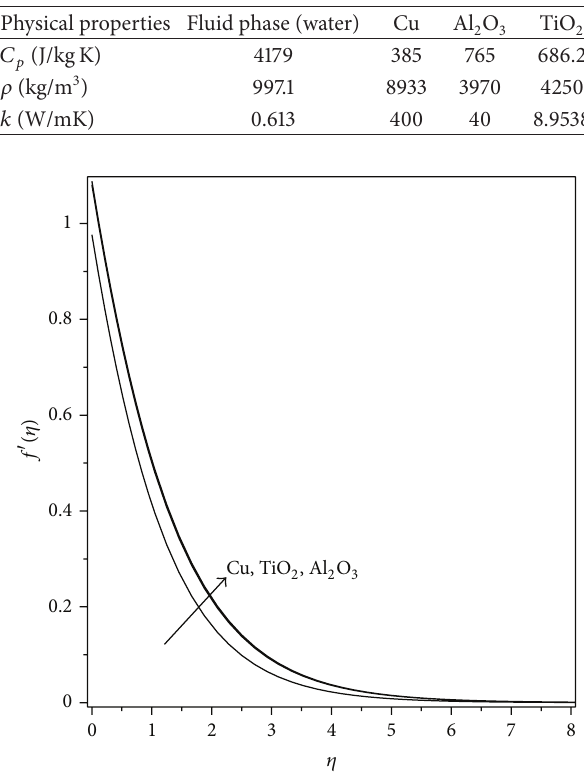
Figure 1: Dimensionless velocity profiles 𝑓 󸀠 (𝜂) for different types of nanoparticles when 𝜙 = 0.1 and 𝑚 = 0 .